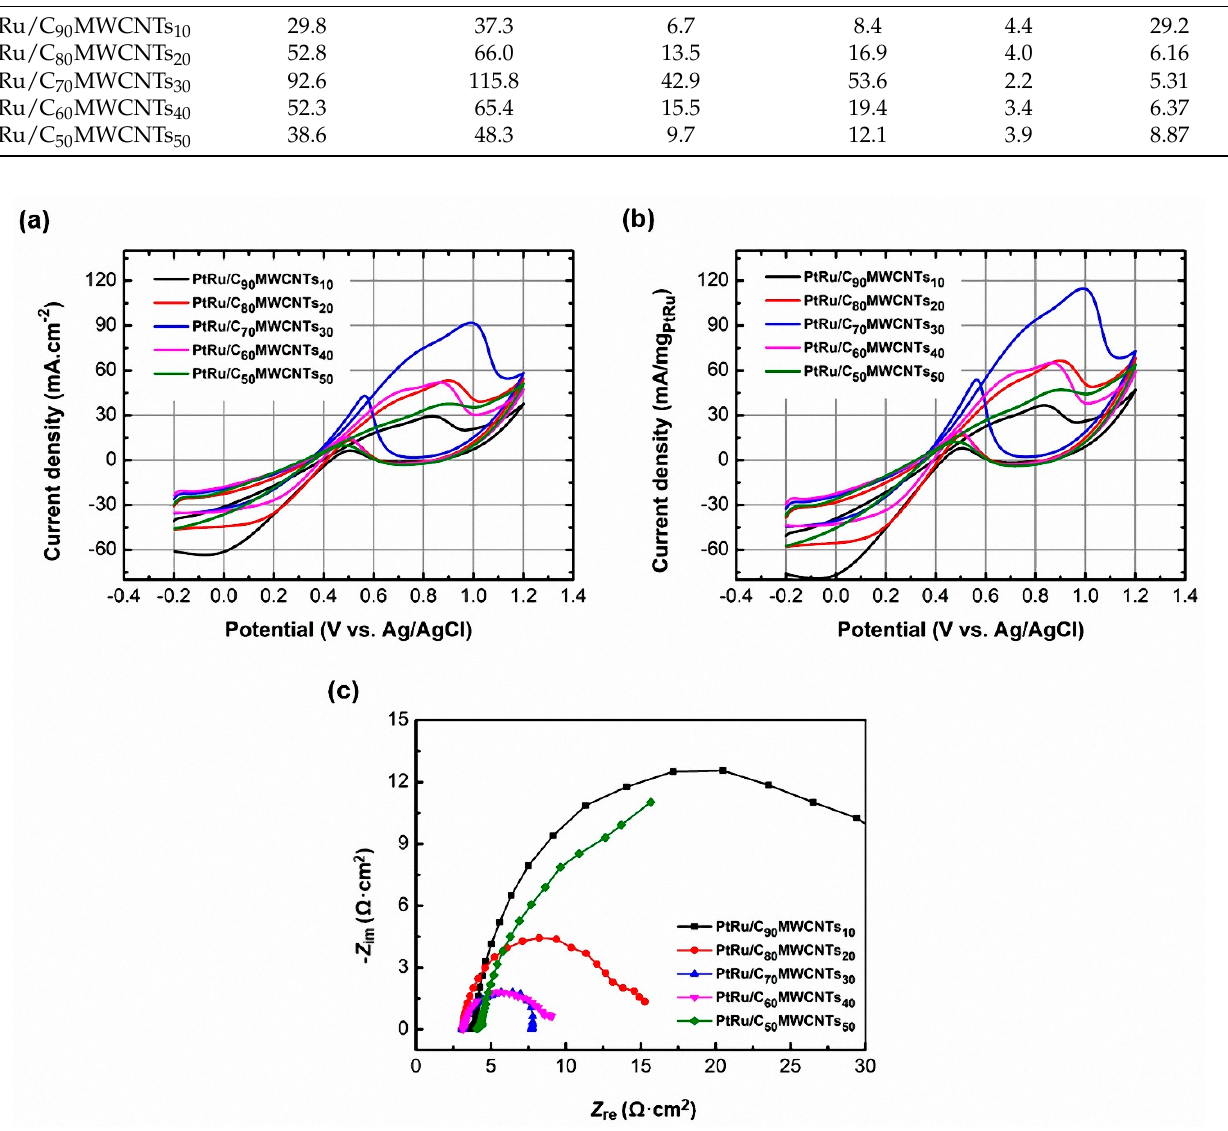
Figure 6. ( a , b ) Cyclic voltammograms of PtRu/C 90 MWCNTs 10 , PtRu/C 80 MWCNTs 20 , PtRu/C 70 MWCNTs 30 , PtRu/C 60 MWCNTs 40 , and PtRu/C 50 MWCNTs 50 with current density units of mA·cm − 2 and mA/mg PtRu . ( c ) Nyquist plots of the EIS for these samples in a frequency range from 0.1 Hz to 100 kHz. The electrolyte was a mixture solution of 0.5 M H 2 SO 4 and 1.0 M CH 3 OH.